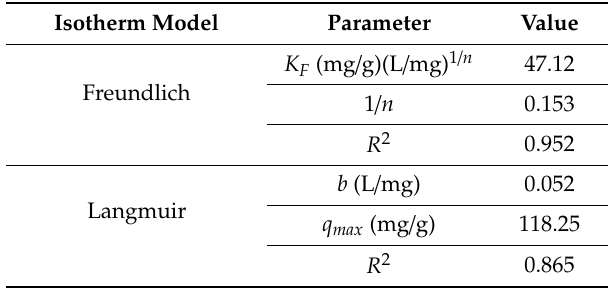
Figure 4. Comparison of the experimental results with the q e values predicted by Freundlich and Langmuir isotherm models for benzaldehyde removal by iron slag. Table 3. Constants of isotherm models with statistical measure for sorption of benzaldehyde onto iron slag.